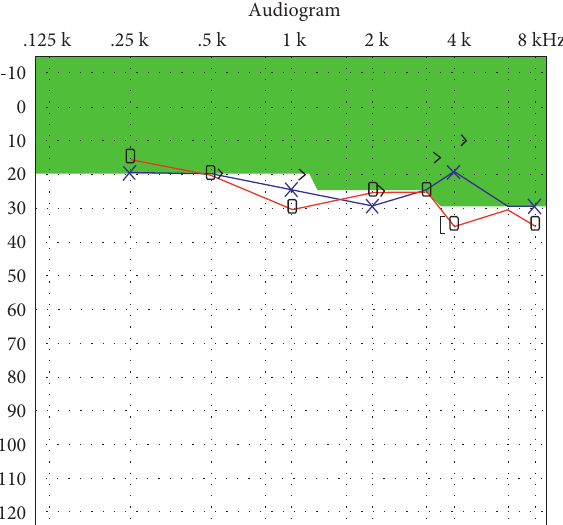
Figure 3: Audiogram two years posttreatment: hearing thresholds returned to baseline with mild sensorineural hearing loss at higher